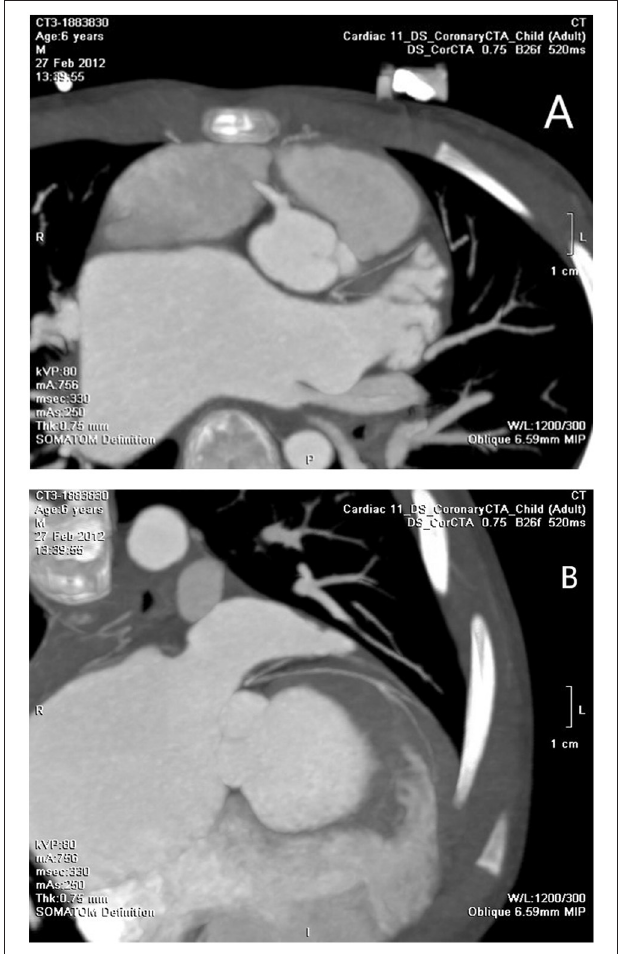
FIGURE 4 | (A) Cardiac CTA: No left coronary artery opening in the left coronary sinus. (B) Cardiac CTA: hypoplasia of left anterior descending coronary artery and left circumflex coronary artery.